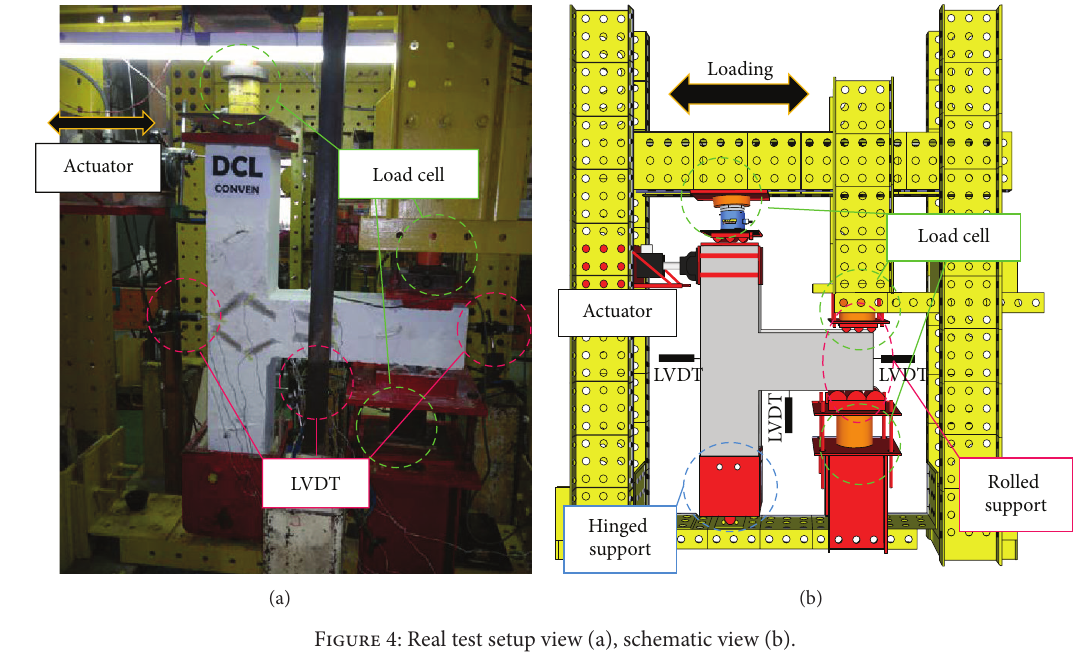
Figure 4: Real test setup view (a), schematic view (b).